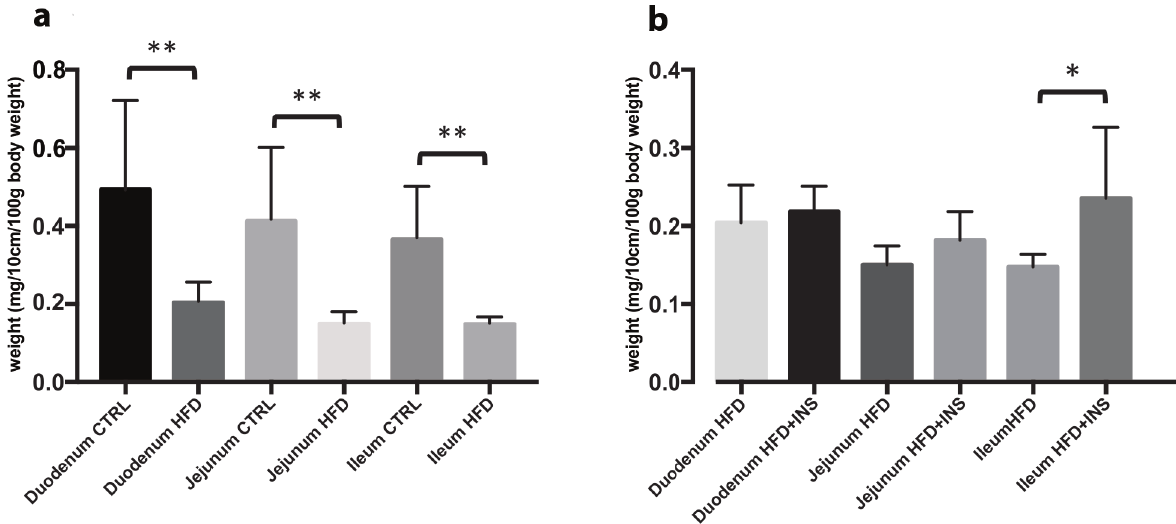
Figure 4 - a . Eff ect of diet in intestinal epithelium segments (10cm) weight (duodenum, jejunum and ileum). CTRL (regular chow), HFD (high fat low carbohydrates diet) (n=10). Values are mean ±SD. **p<0,001. b . Eff ect of insulin in intestinal segments (10 cm) weight (duodenum, jejunum and ileum). HFD (high fat low carbohydrates diet) (n=10), HFD+INS (high fat low carbohydrates diet plus oral insulin gavage) (n=10). Values are mean ±SD.